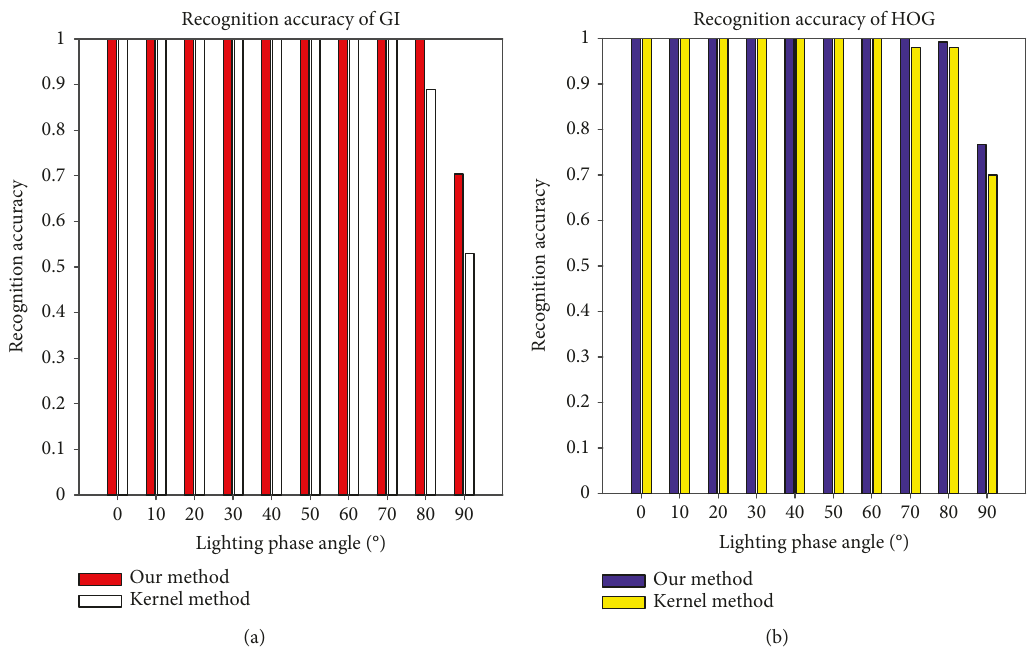
Figure 8: Lighting robustness results of satellite